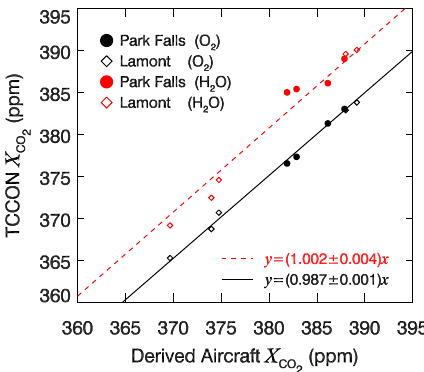
Fig. 3. Comparison of X CO estimates to derived aircraft column 2 averages. Red points indicate that H 2 O is used as dry air standard. Black points indicate that O 2 is used as dry air standard. Dots are for Park Falls site and diamonds for Lamont site. Error bars are not shown in this